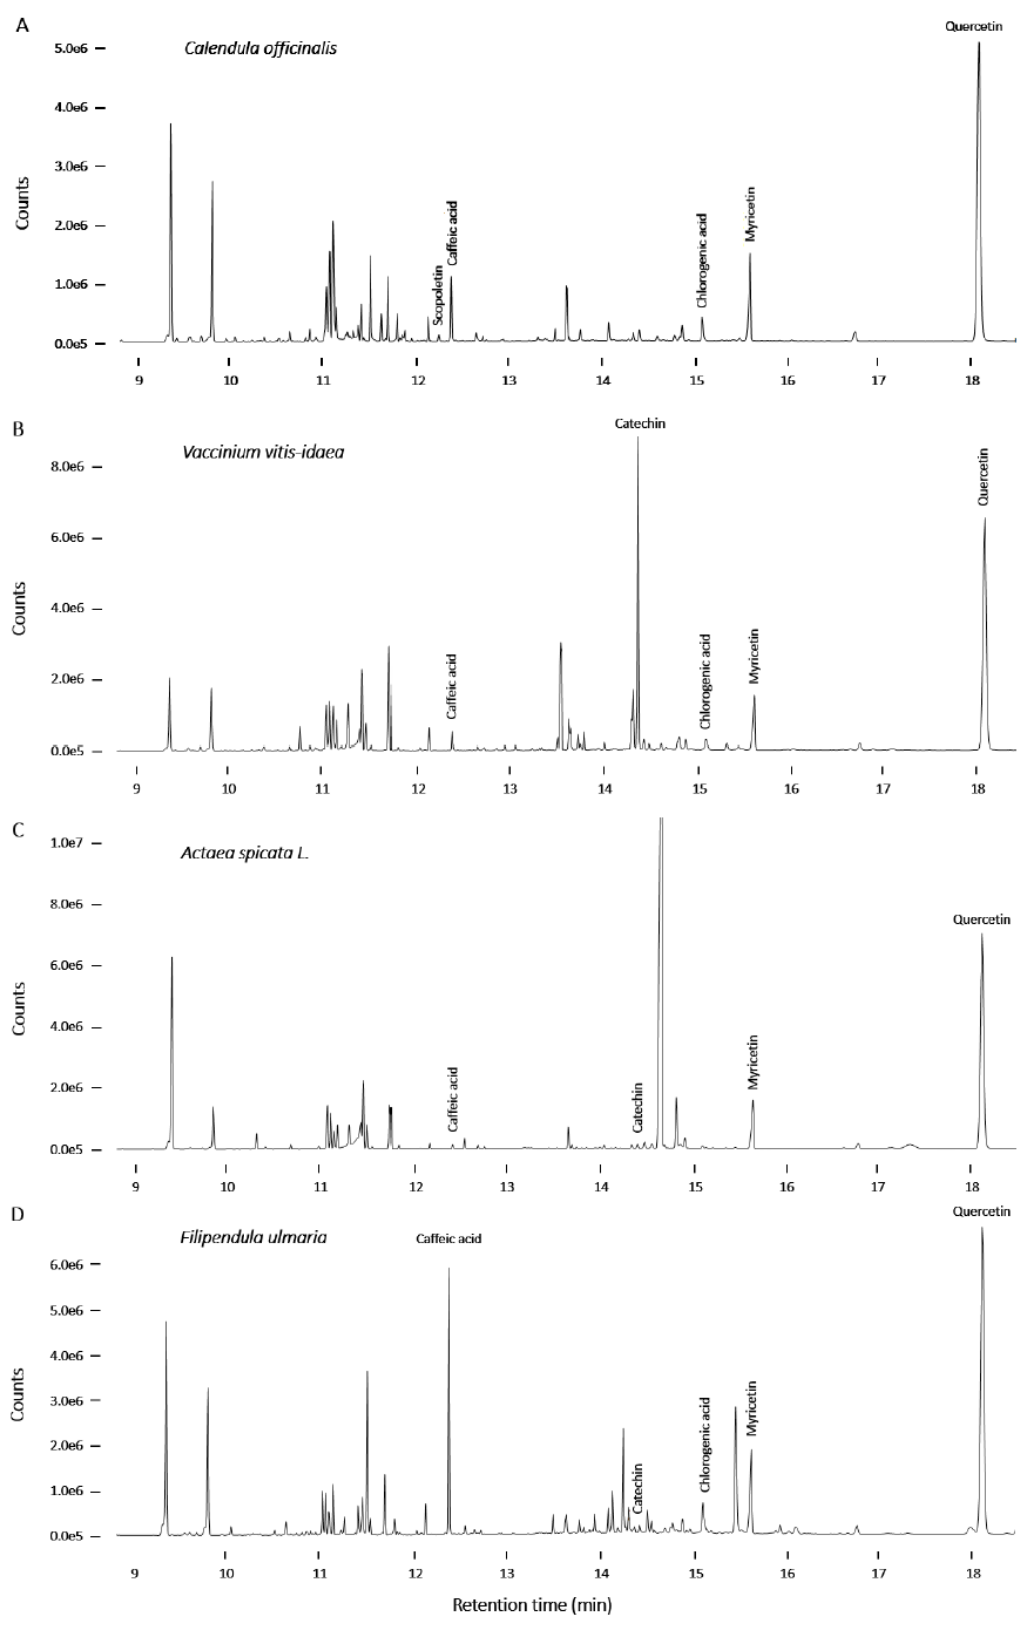
Figure A6. GC-MS chromatograms of Calendula officinalis ( A ), Vaccinium vitis-idaea ( B ), Actaea spicata L. ( C ) and Filipendula ulmaria ( D ).